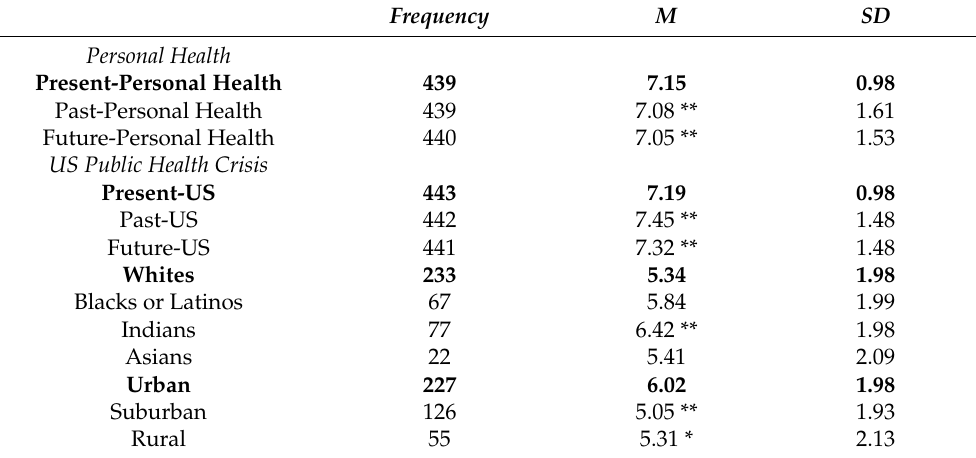
Table 3. Means of Hopes and Fears by Ethnicity and